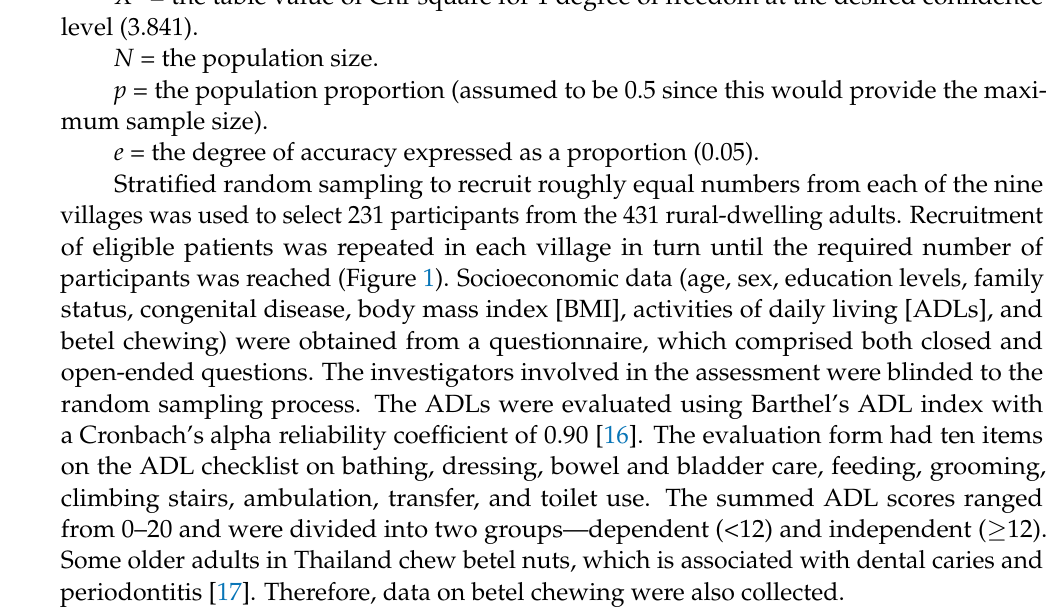
X 2 = the table value of Chi-square for 1 degree of freedom at the desired confidence level (3.841).